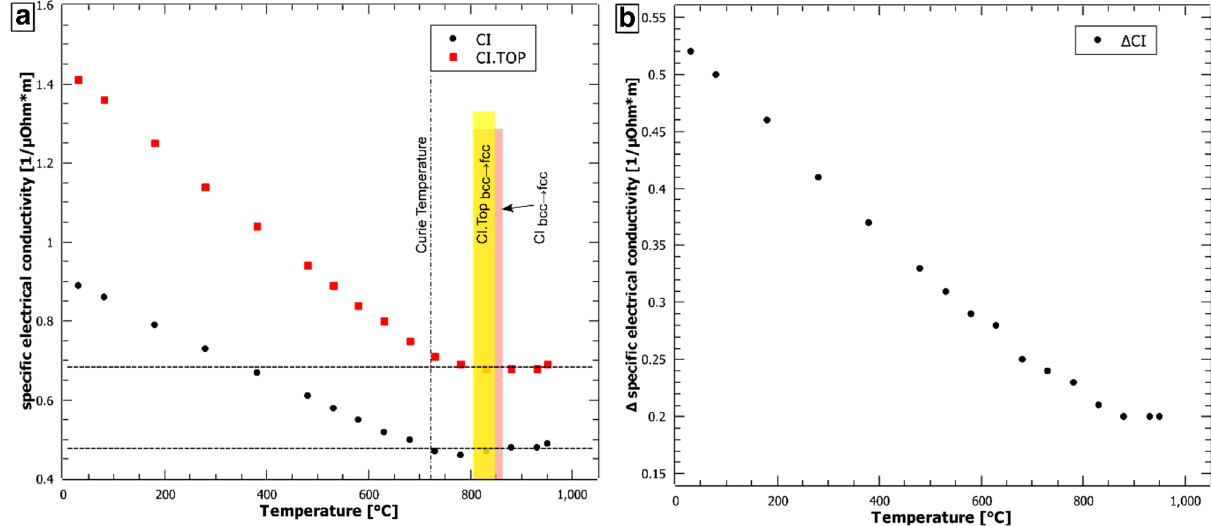
Fig. 5 Electrical conductivity measured over a temperature range from room temperature to 950 °C. Shown are both, Cast iron in its initial condition and after "end of service life"-condition ( a ). As can be seen the difference between both materials is decreasing almost linearly ( b